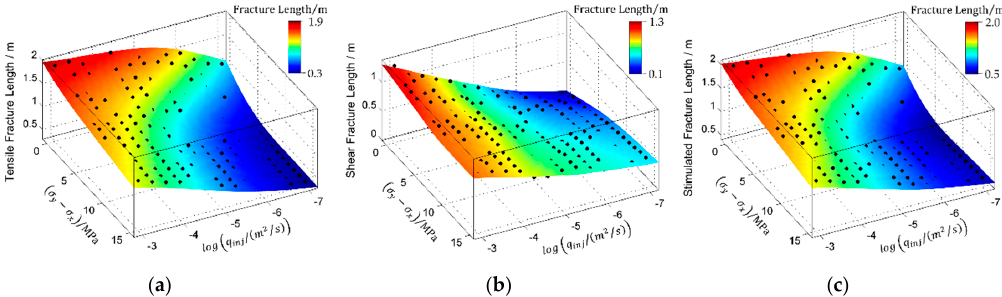
Figure 7. Final fracture network configurations under different injection rates. ( a ) q inj = 1.0 × 10 − 7 m 2 /s; ( b ) q inj = 1.0 × 10 − 5 m 2 /s; ( c ) q inj = 1.0 × 10 − 3 m 2 /s. For the fluid-affected fractures, the fluid pressure ( p f ) is represented by color. The fractures that are not affected by fluid are represented by the gray meshes. The shear fractures are marked by the bold curves at the top. The stress difference σ y − σ x is equal to 10 MPa in these simulations.